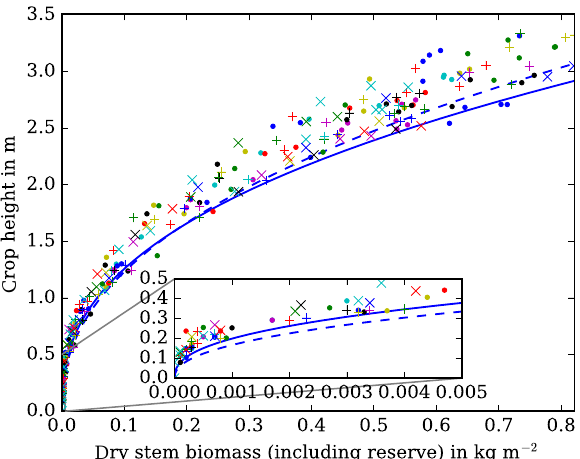
Figure 12. Balanced LAI (calculated from canopy height) against LAI. Dots, vertical crosses (+) and diagonal crosses (x) are US-Ne1, US-Ne2 and US-Ne3 observations respectively. Red: uses natural PFT parameters from Osborne et al. (2015); blue: uses new, tuned parameters. Dotted line shows x = y . Only points up until the max- imum LAI measurement for that site in that year are